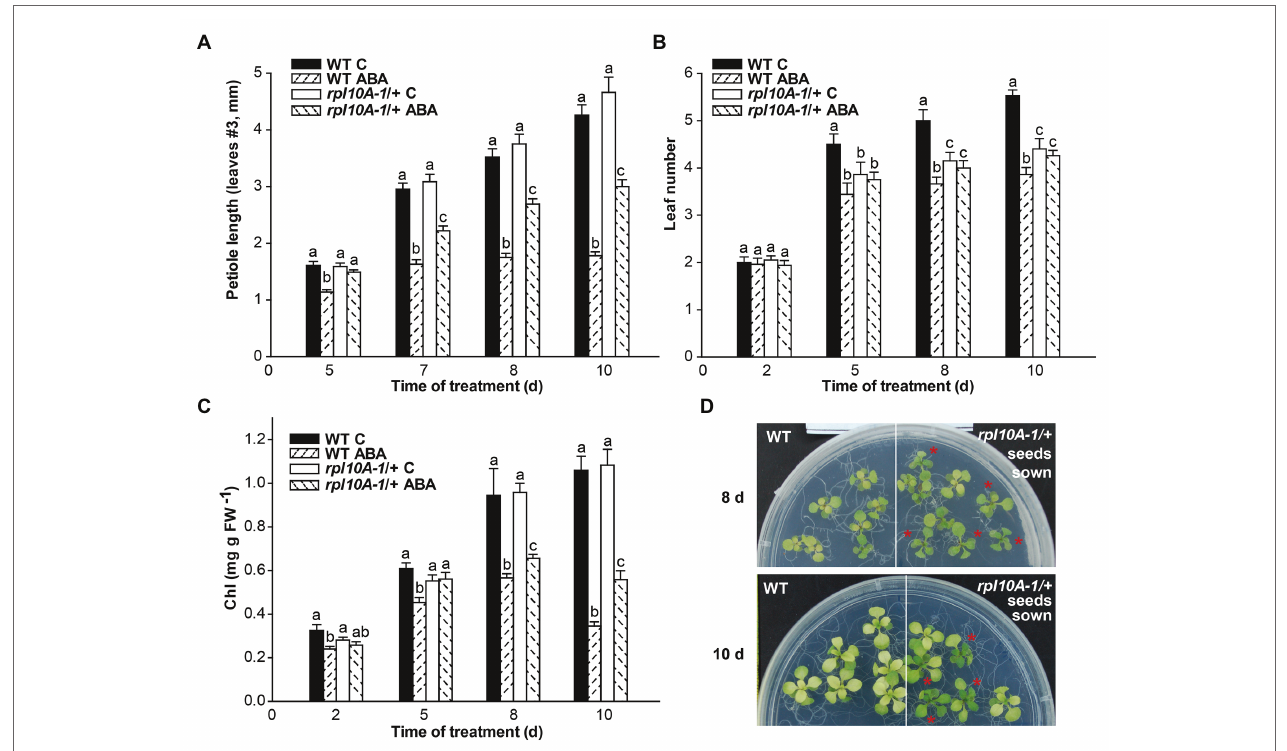
FIGURE 5 | ABA sensitivity time course of rpl10A/+ seedlings. Seven-day-old seedlings grown in MS-agar medium were transferred to MS-agar (MS) or MS-agar medium supplemented with 10 μ M ABA (MS + ABA). Petiole length (A) , leaf number (B) , and chlorophyll (Chl) content per mg fresh weight −1 (FW; C ) were measured over the time for 10 days. (D) Representative images of WT and rpl10A-1/+ mutant plants at 8 days (upper panel) and 10 days after the transfer to MS-agar medium supplemented with 10 μ M ABA (lower panel). Asterisks indicate heterozygous rpl10A-1 mutant seedlings. Results are the mean of three independent experiments ± SE ( n = 30 for each biological experiment). For each genotype and condition (with or without 10 μ M ABA), different letters indicate statistical differences applying ANOVA test at p <